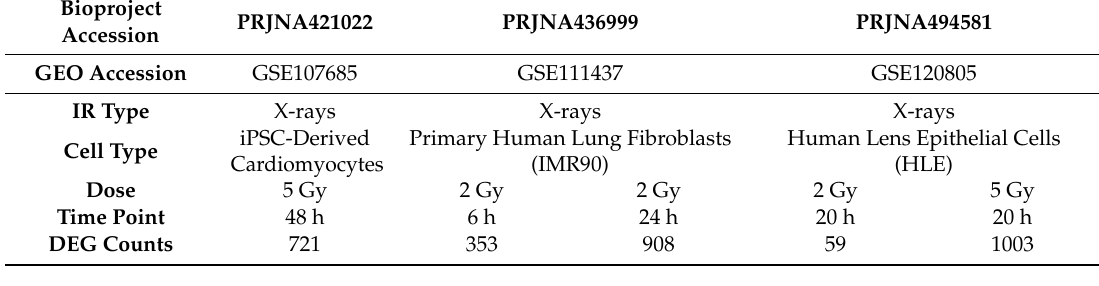
Table 2. Statistically significant gene counts derived from the di ff erential gene expression analysis for each comparison within each dataset. The table includes information about experimental sample parameters, dataset accession numbers, and total mapped gene counts for each dataset.